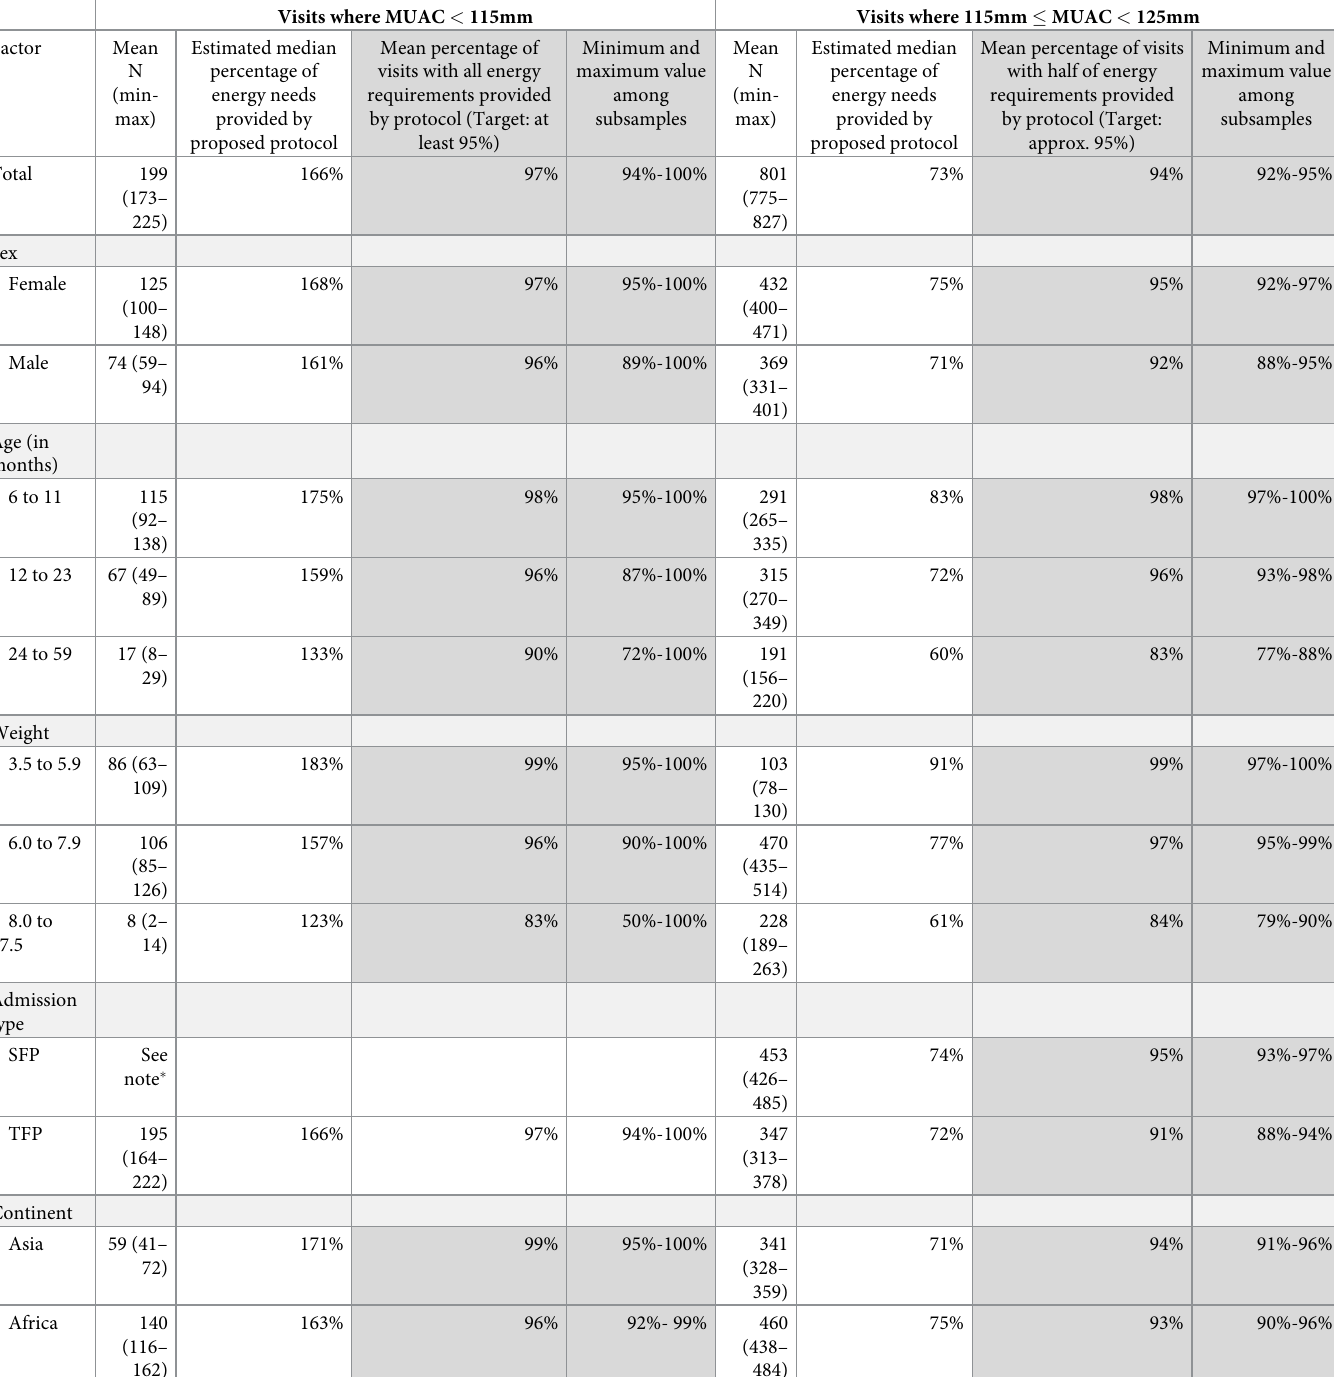
Table 2. Estimated energy provided by proposed protocol as percentage of energy needed in observational data using 100 trials using subsamples of 200 visits from each of five countries (1000 visits total per simulated